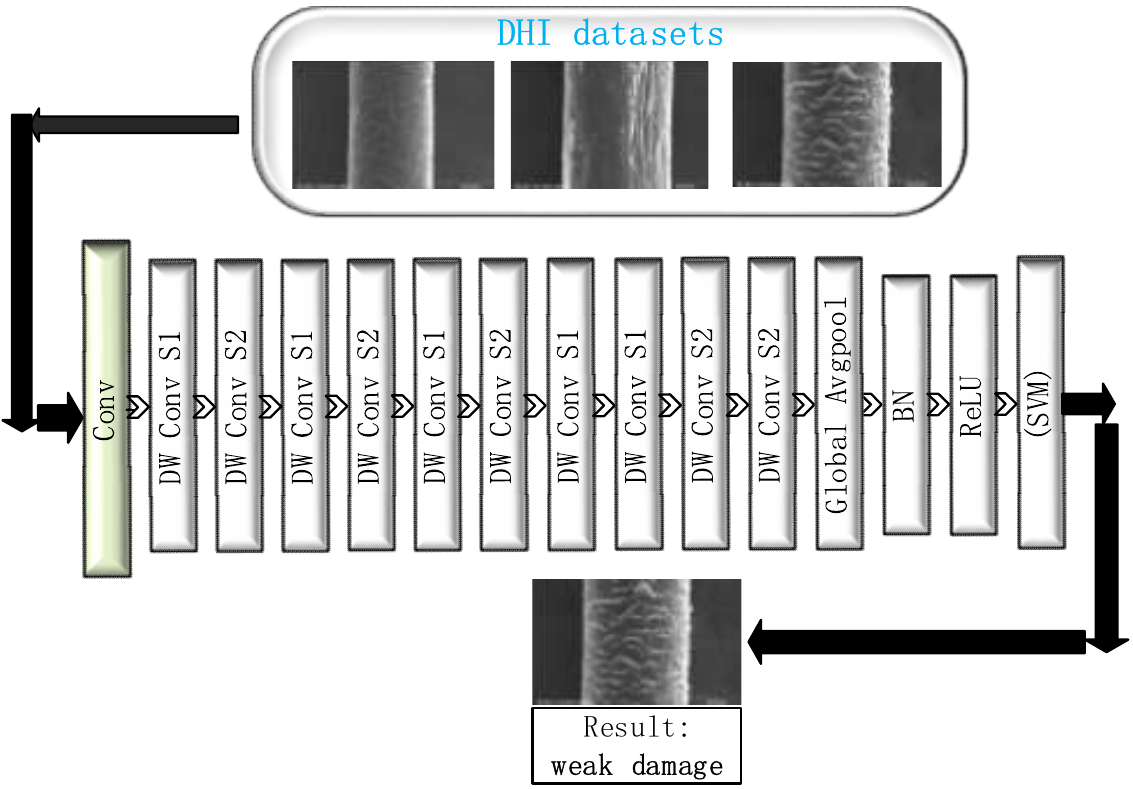
Figure 5. Proposed model architecture: Hair-Diagnosis Mobilenet (HDM-NET + SVM) and process of training the CNN model (HDM-NET), convolution (Conv), depthwise (DW), and batch normalization (BN). The classifier can also be changed for RF, MLP, and KNN.